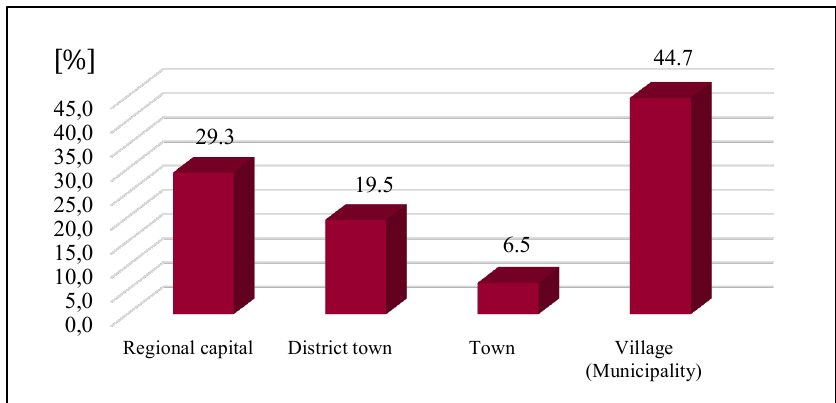
Fig. 2. Results in answers to the item no.1: „Write the name of the primary school you